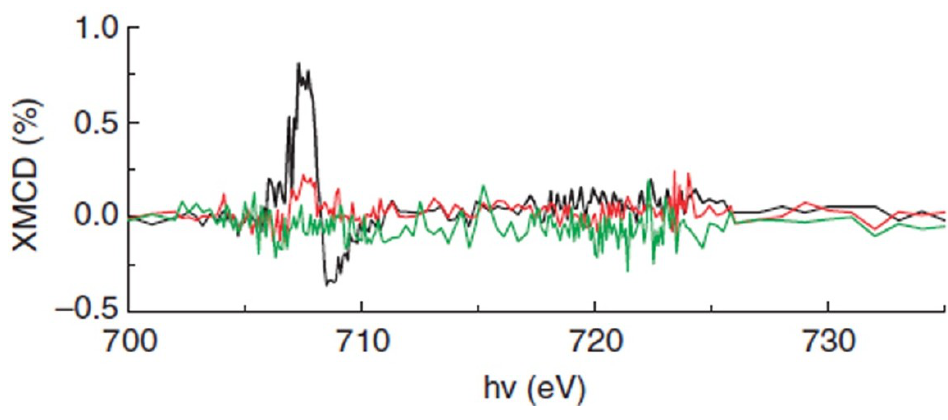
Figure 8. X-ray magnetic circular dichroism study of different phases of BFO thin films. (Reprinted with permission from [70]. Copyright 2011 Macmillan Publishers Limited) Mixed phase (black), pure rhombohedral phase (red) and pure tetragonal phase